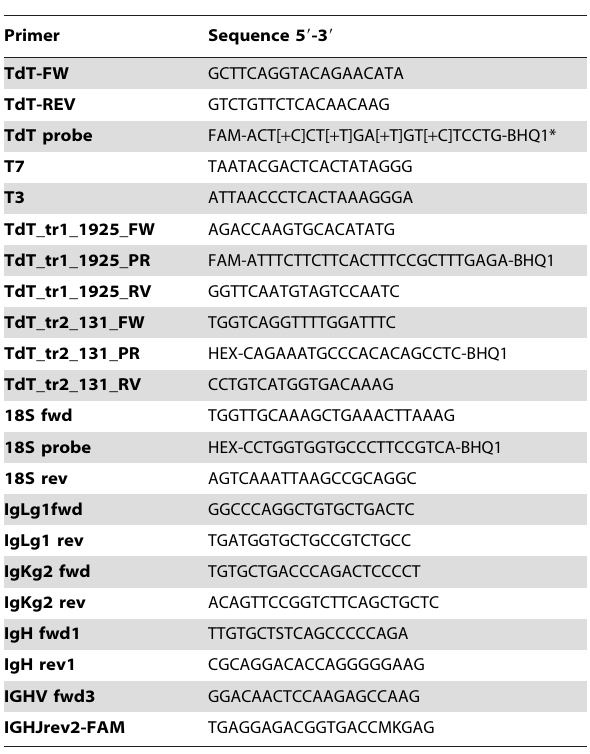
Table 1. PCR primers and